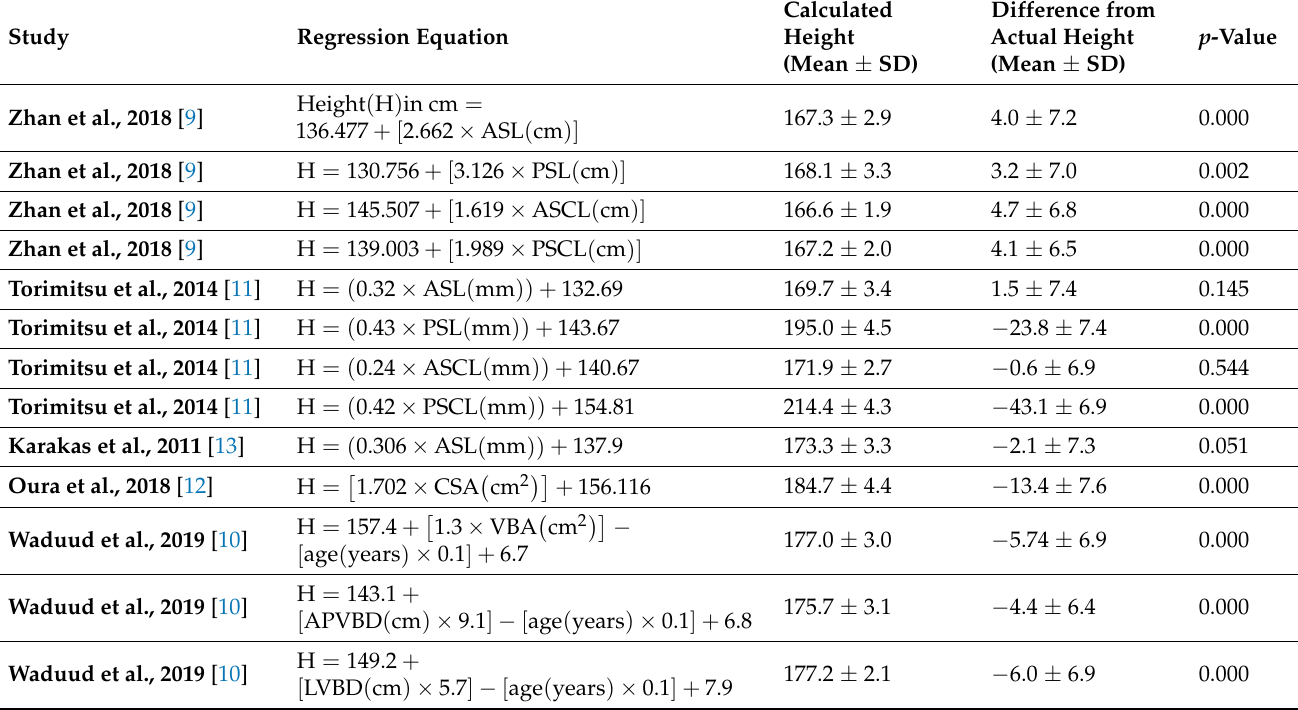
Table 6. Accuracy of formulae equations for height calculation in male